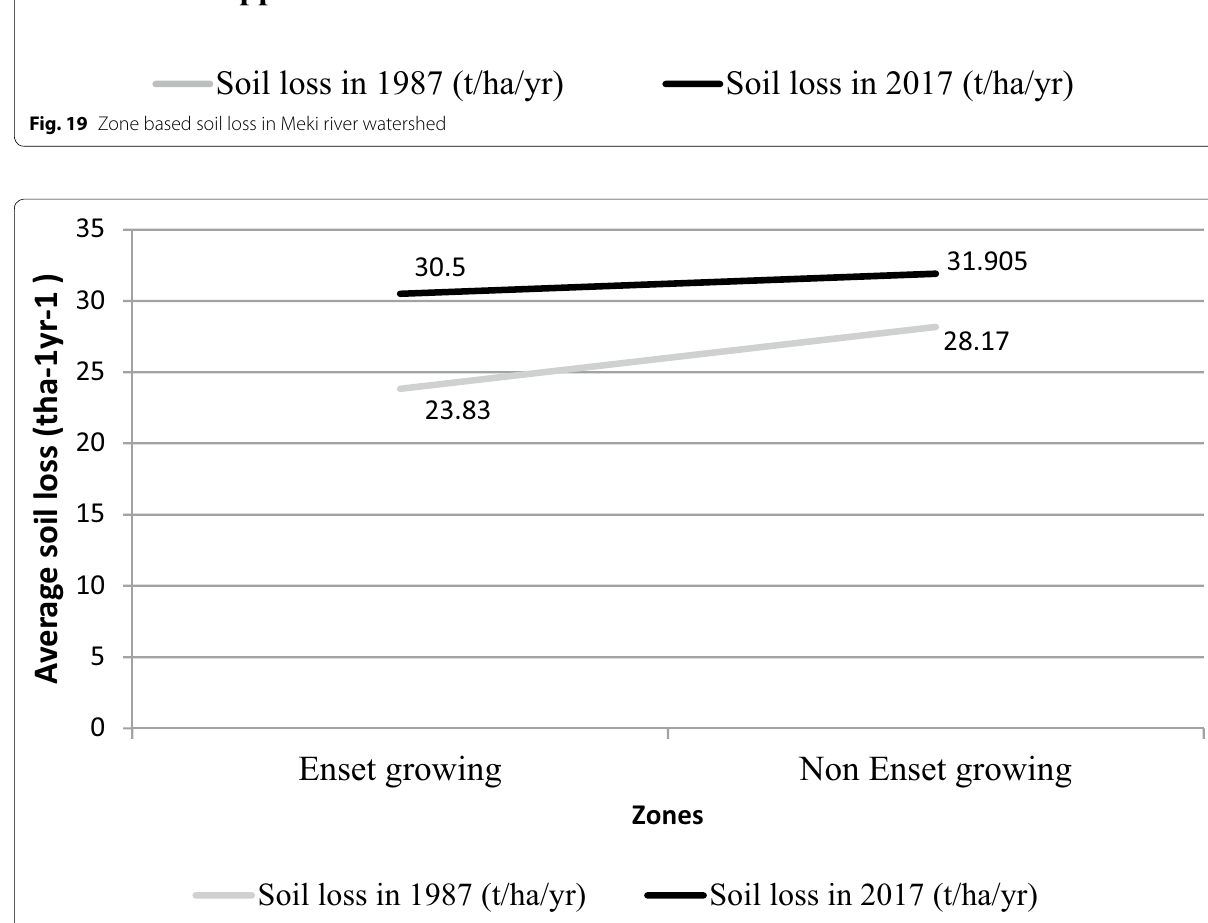
Fig. 20 EBLUS and its contribution to reduce soil erosion in Meki river